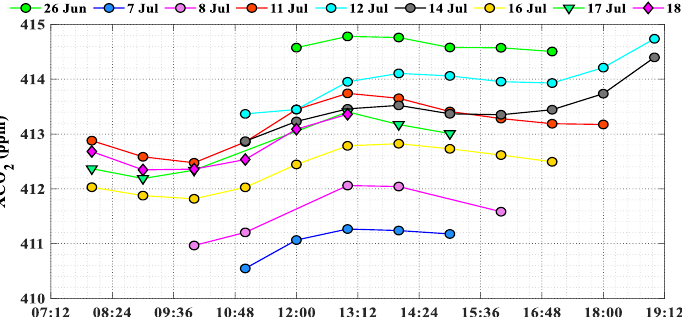
Figure 5. Diurnal variation of XCO 2 measured by EM27/SUN at CRCS ground station.